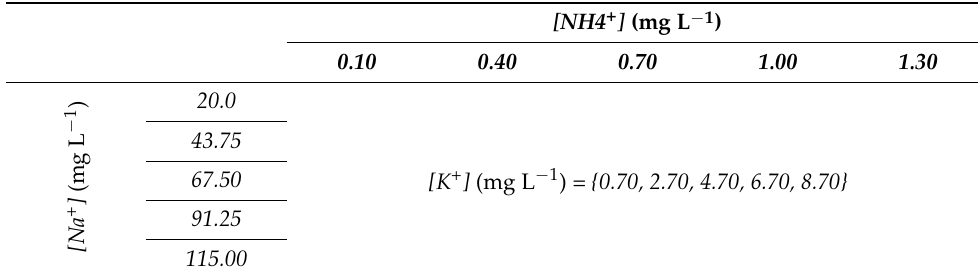
Table 2. Design of the